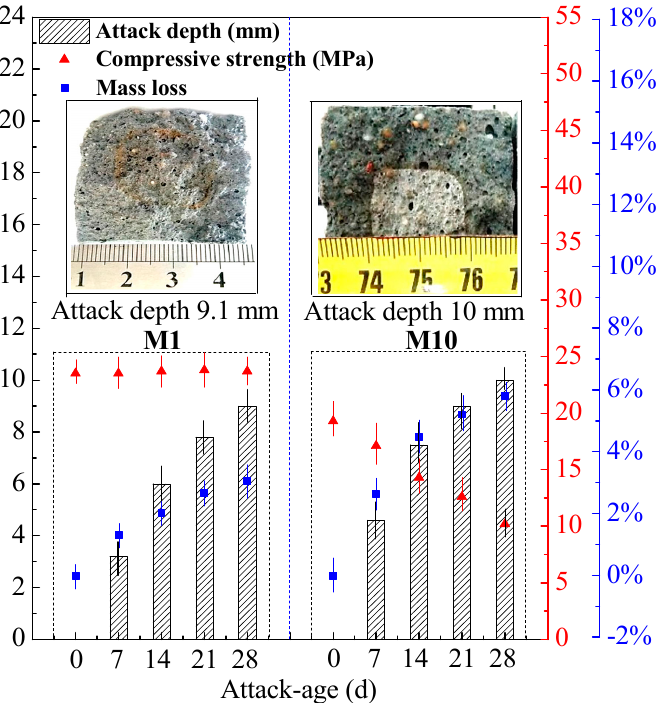
Figure 4. Compressive strength, mass loss and attack depth of M1 and M10 (cured for 360 d) under HCl-attack for 28 d.